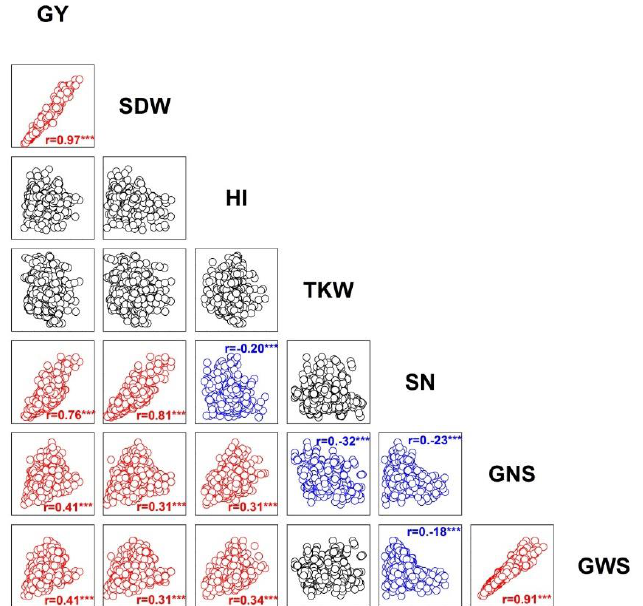
Figure 7. The correlation matrix between the grain yield (GY), shoot dry weight (SDW), harvest index (HI), thousand grain weight (TKW), spike number per m − 2 (SN), grain number per spike (GNS), and grain weight per spike (GWS). *** p < 0.001.